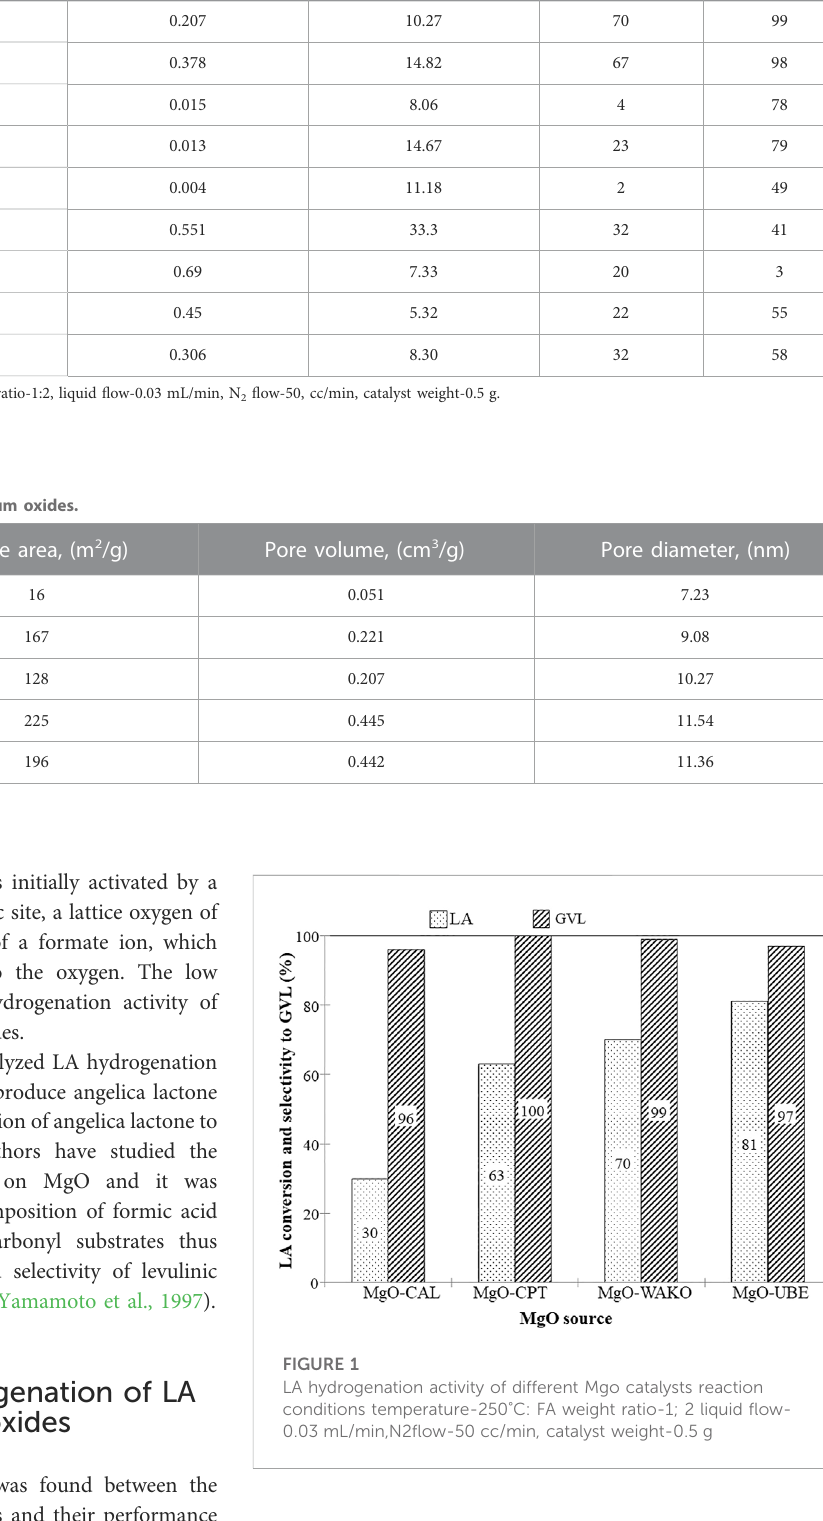
TABLE 1 Catalytic transfer hydrogenation of LA to GVL using different metal oxides. Catalyst name Surface area (m2/g)